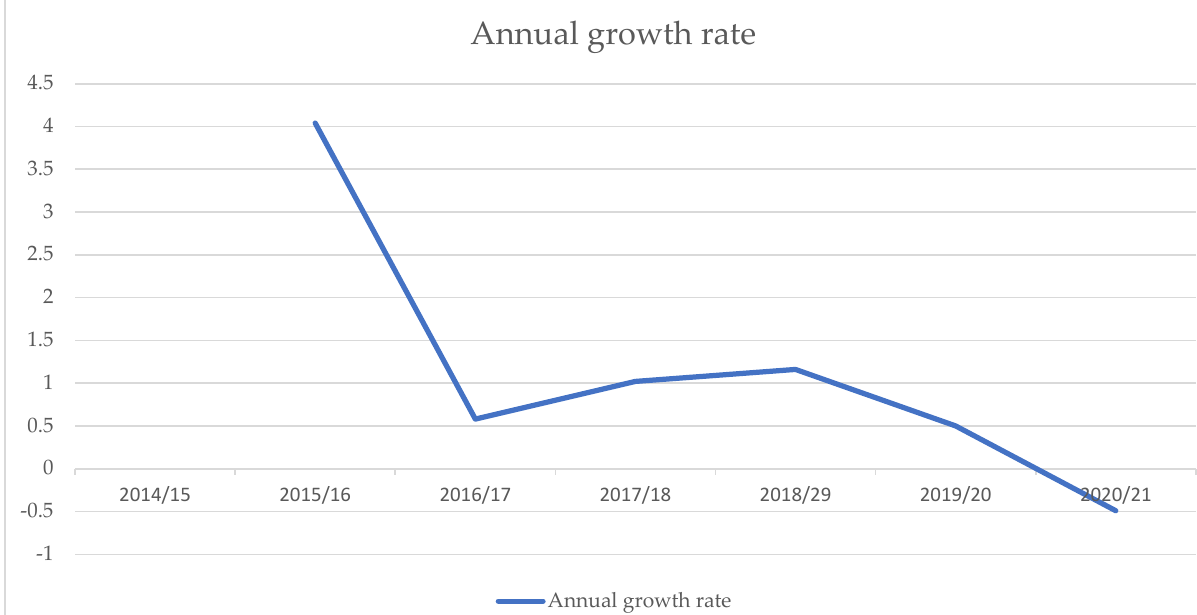
Figure 7. IPDC-owned IPs’ annual export growth rate (2014/15–2020/21); Source: IPDC, computed by authors; 2021.